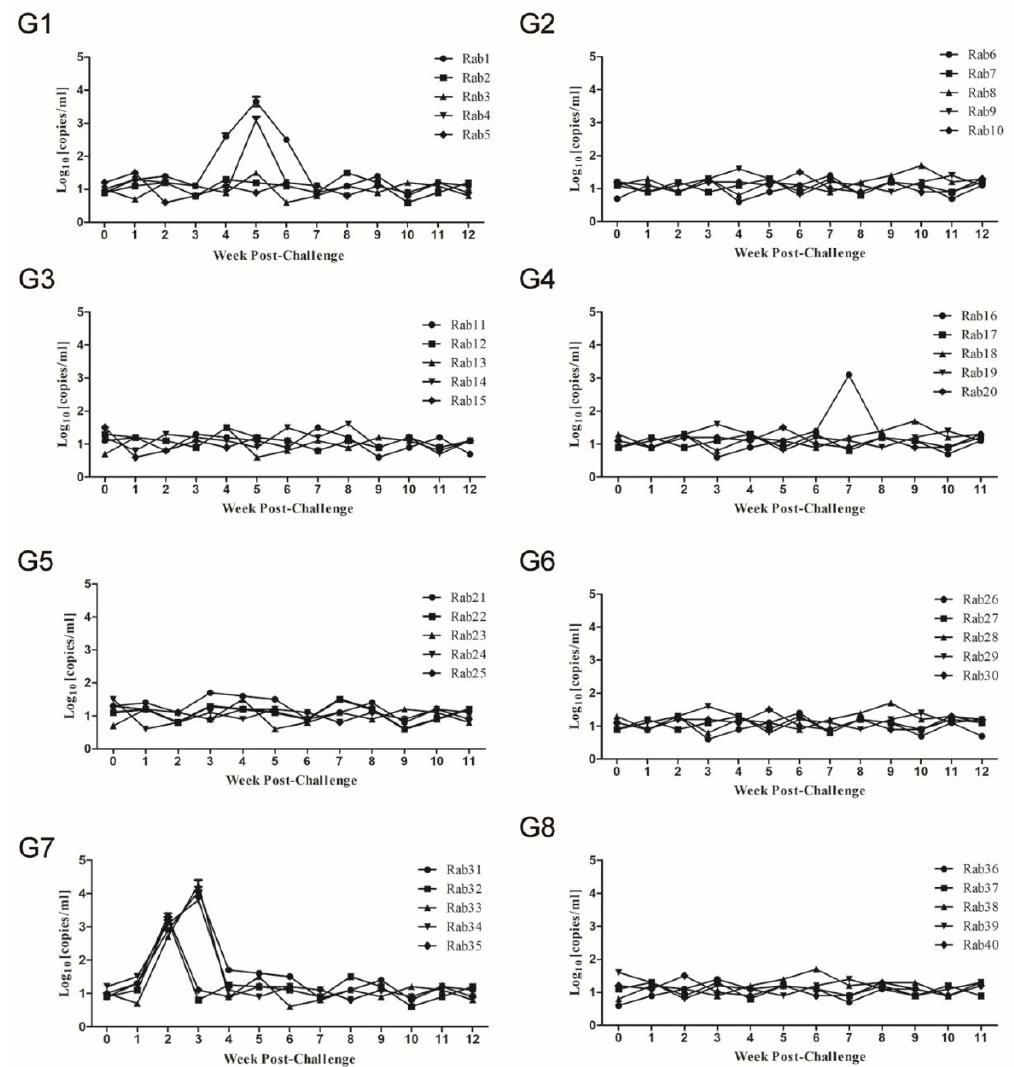
Figure 4. Dynamic changes in viral loads of serum samples from inoculated rabbits after challenge with CHN-SD-sHEV. SPF rabbits immunized with Pep VKLYTS ( G1 ), Pep PSRPF ( G2 ), Pep EPTV ( G3 ), Pep EPTVKLYTS ( G4 ), Pep EPTVKLYTSPSRPF ( G5 ), sp239 protein ( G6 ), or PBS (( G7 ), negative control); Rabbits challenged with PBS ( G8 ) as a normal control. Serum samples were collected before virus inoculation and various weeks post challenge wpc. Y-axis represents log10 [copies / mL] of swine HEV RNAs in serum. The error bar indicates the confidence interval of reduplicates of three test wells.